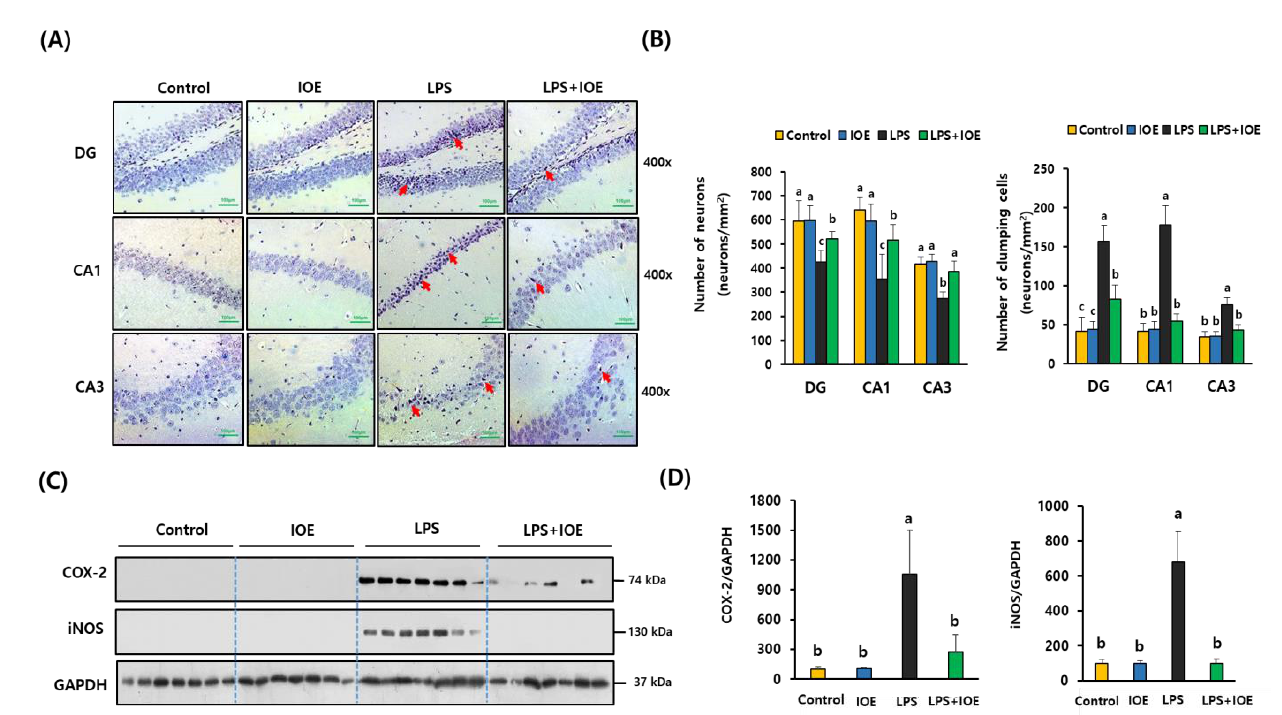
Figure 3. LPS-induced neuronal loss and expression of inflammatory mediators in mice brain were inhibited by oral administration of IOE. DG, CA1 and CA3 region in mice brain of each mice group were visualized by hematoxylin–eosin (H&E) staining ( n = 7) ( A ). The number of viable cells and clumping cells which has pyknotic nuclei in each region was counted and tabulated ( B ). The expression of COX-2 and iNOS in mice brain of each mouse group was evaluated by western blotting ( n = 7) ( C ) and the density of each band was estimated by using image J program and tabulated ( D ). Red arrows indicate the pyknotic nuclei. Magnification 400×. Scale bar = 100 µm. Data shown are the mean ± SD and different letters (a–c) indicate the significant differences between groups ( p < 0.05). Each value is assigned as a–c sequentially from the highest value.